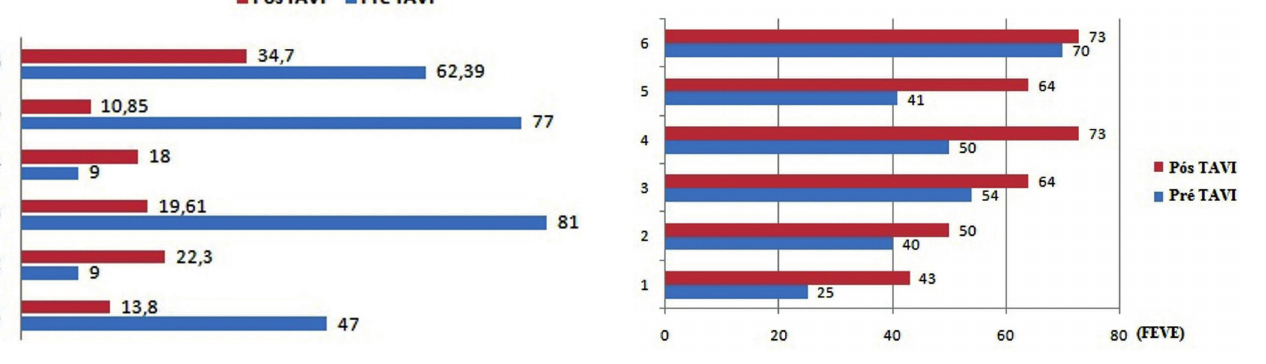
Fig. 6 – Echocardiographic representation of the transvalvular gradients (Before, blue; after,